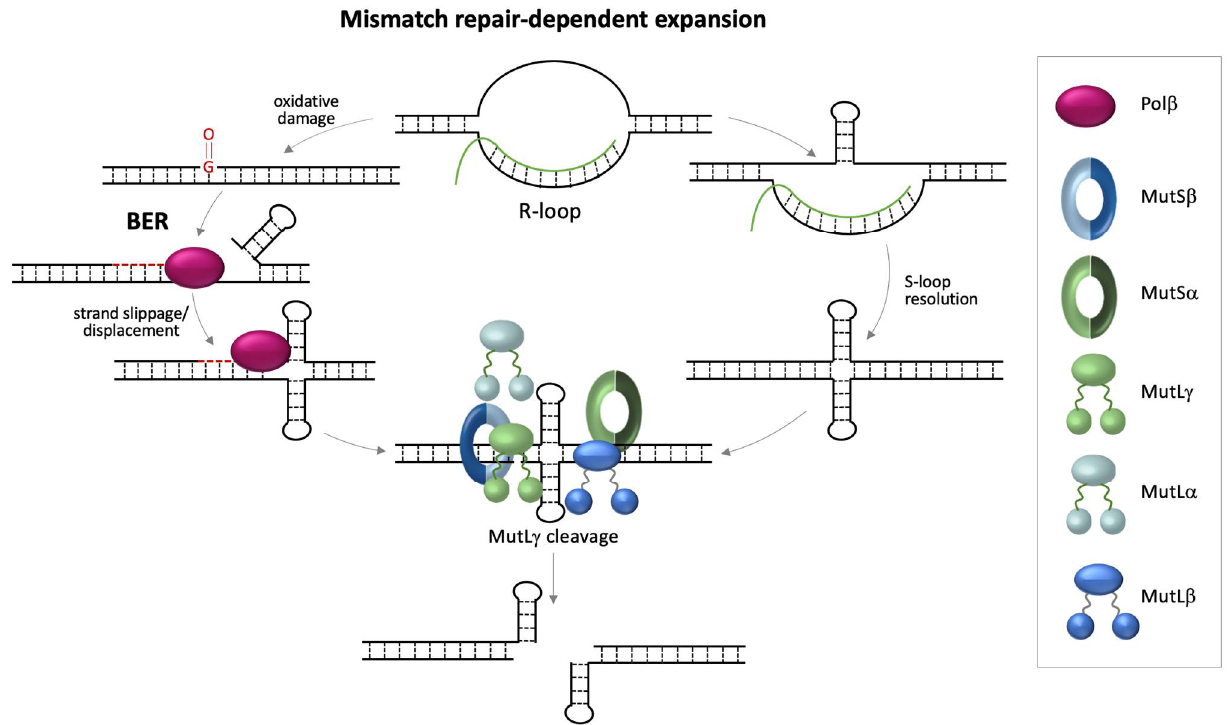
Figure 2. Diagrammatic representation of possible transcription-related, MMR-dependent events that could give rise to repeat expansions. As illustrated on the left-hand side of this figure, R-loops could give rise to expansions because single stranded regions of the R-loop would be prone to oxidative damage. Repair of this damage by BER would create an opportunity for strand slippage and strand-displacement that could result in the formation of hairpins or loop-outs on one or both strands [83] . Alternatively, as illustrated on the right, hairpin formation might occur on the non-template strand of the R-loop, forming an S-loop. This might favor formation of a hairpin on the template strand after dissociation of the transcript. Hairpins or double loop-outs formed by either process could then be bound by both MutS proteins. This results in the recruitment of MutL α , MutL β , and MutL γ . MutL γ cleavage of the strands opposite each loop-out would generate a DSB that would then be repaired by some, as yet unknown, non-homologous end-joining-independent DSBR